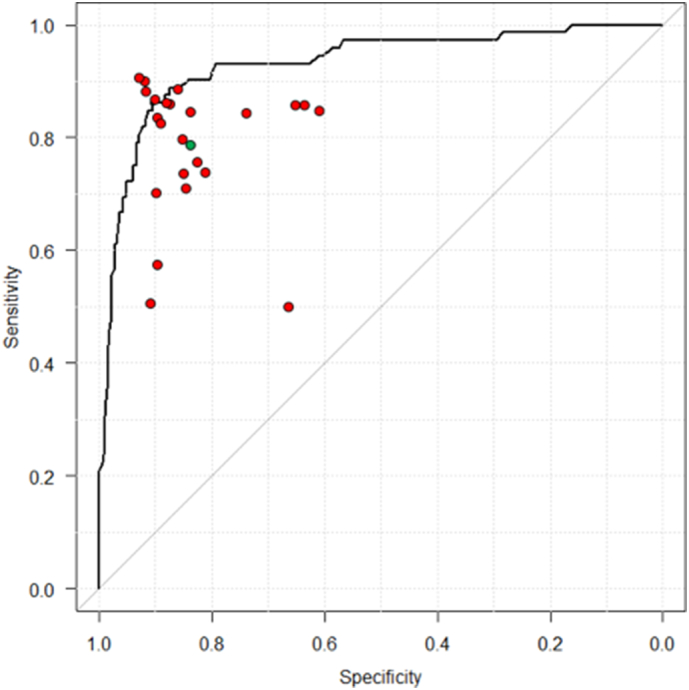
Receiver operating curves for CNN trained by categorized data.The CNN output demonstrates better probability following a training based on location-based classification of images. The area under the receiver operating curve is now 93%. Each endoscopist's prediction is represented by a single red point. The green point is the average prediction of the endoscopists.